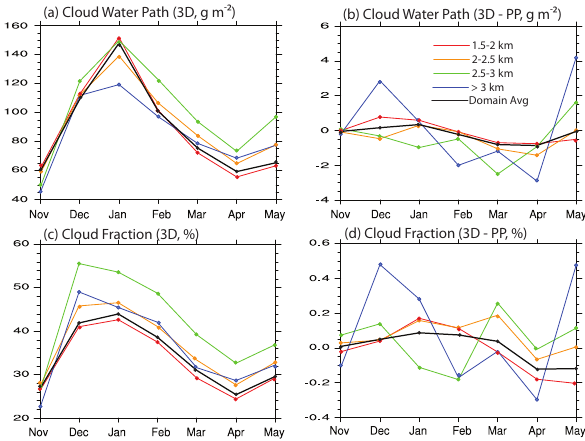
Fig. 11. (a) The monthly averaged Cloud Water Path (CWP, gm − 2 ) over the entire domain simulated from the 3-D experiment as a func- tion of elevation. (b) The corresponding deviations (3-D-PP) for CWP. (c) The monthly averaged cloud fraction (%) over the entire domain simulated from the 3-D experiment as a function of eleva- tion. (d) The corresponding deviations (3-D-PP) for cloud fraction. 1.5–2km (red), 2–2.5km (orange), 2.5–3m (green), above 3km (blue), and the whole domain